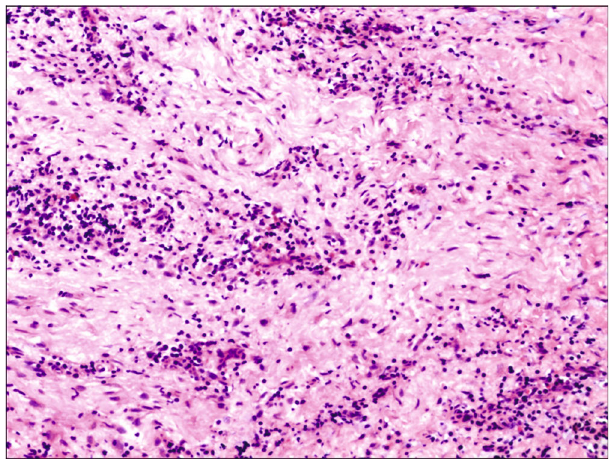
Figure 2: Histological evaluation of peri-implant tissue revealed in fi ltration of lymphocytes and plasma cells ( ×